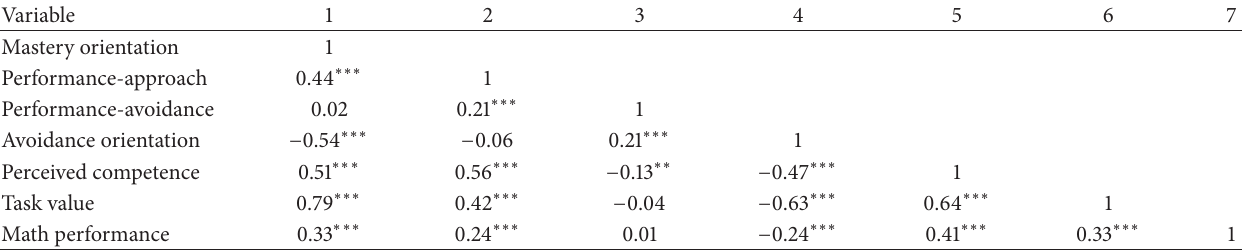
Table 2: Pearson’s correlation coefficients between variables in the whole data ( 𝑁 = 396–425).